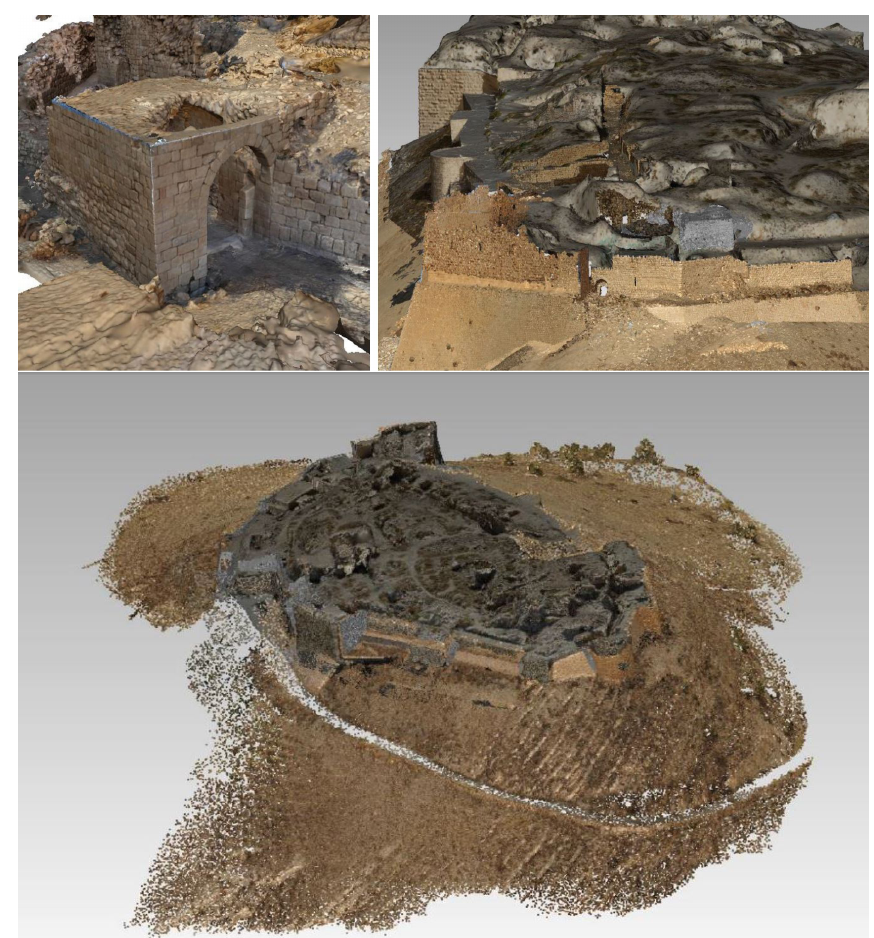
Figure 6. 3D models of the entire